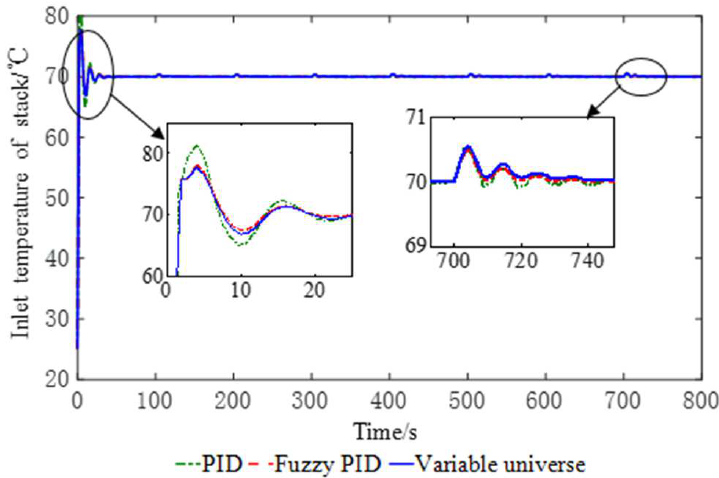
Figure 10. Inlet coolant temperature.